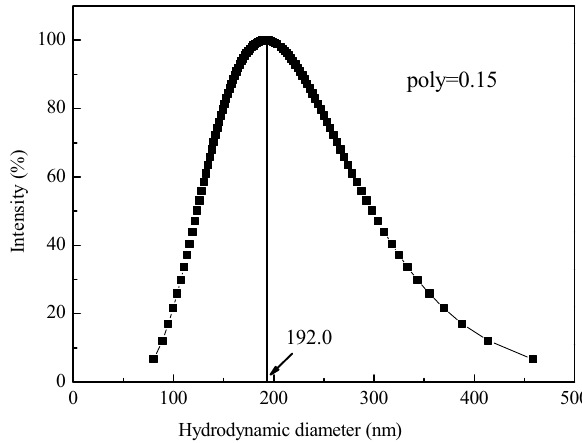
Figure 1. The size distribution of the primary black soil colloid